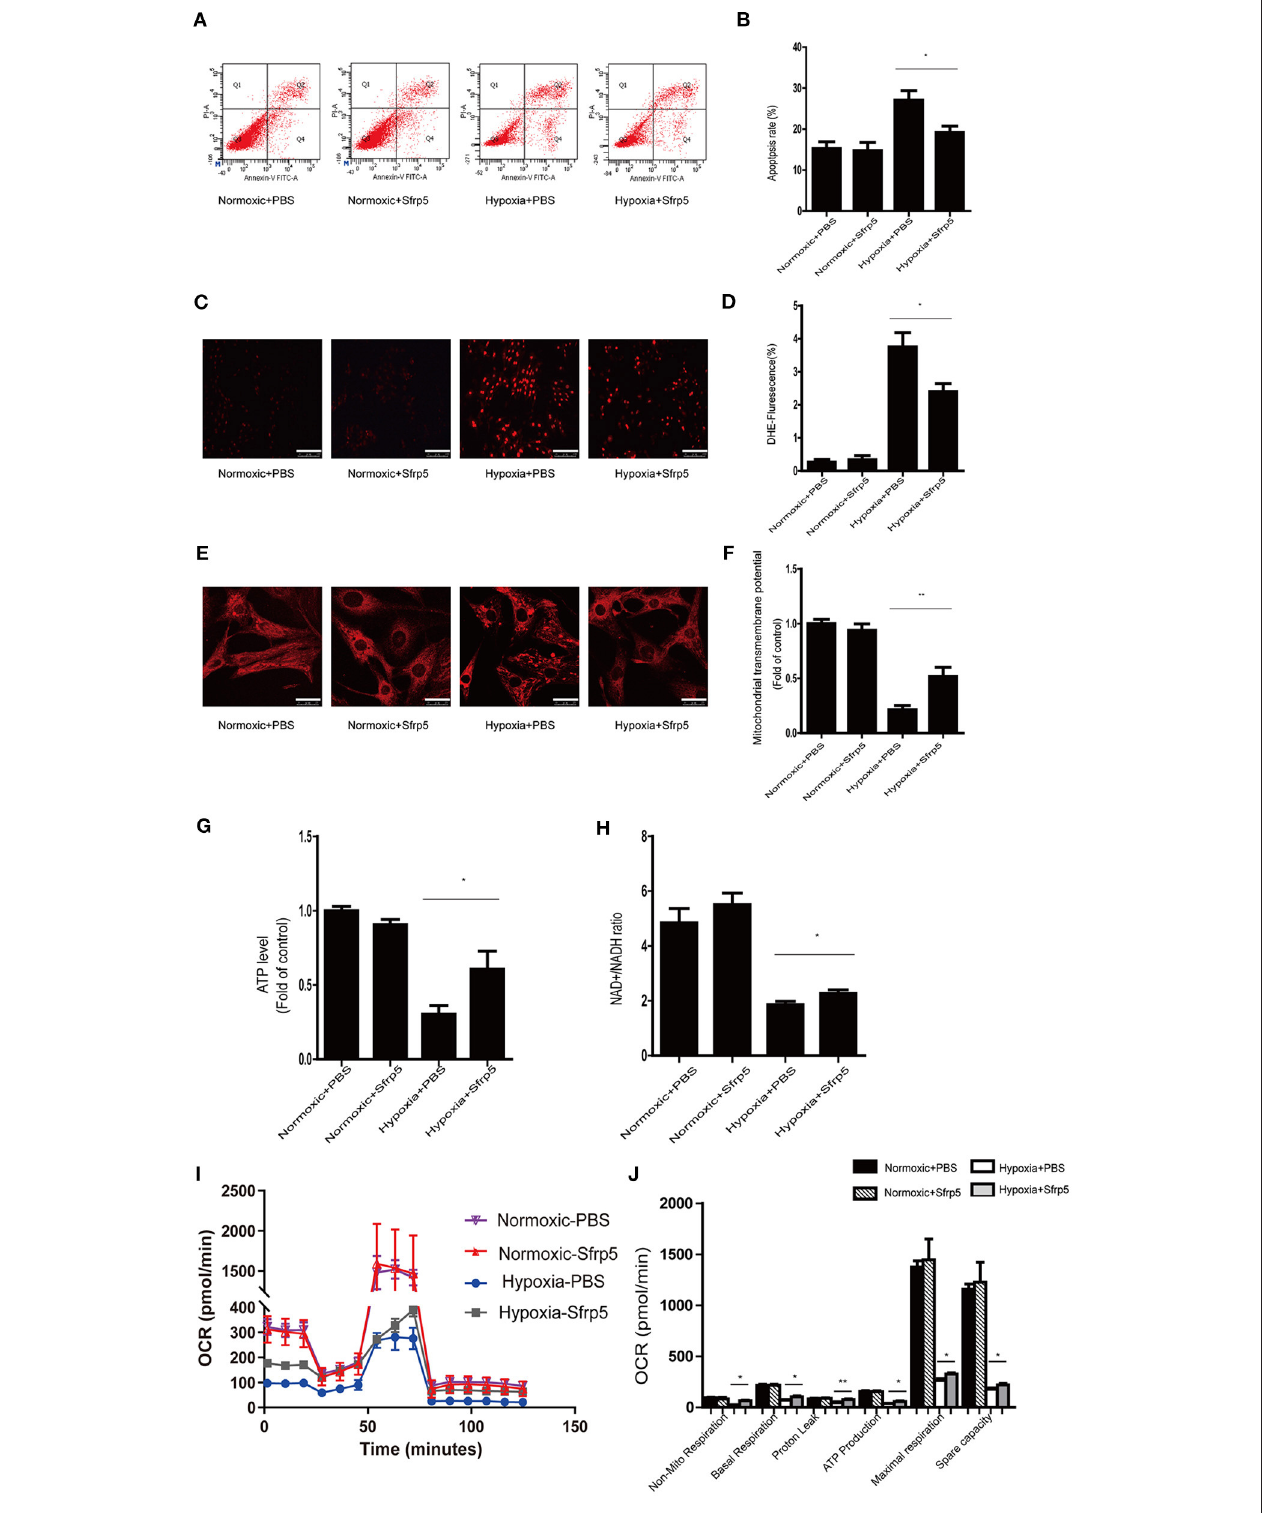
FIGURE 5 | Sfrp5 treatment attenuated hypoxia-induced myocardial oxidative stress and mitochondrial dysfunction in vitro . (A) The rate of apoptosis was detected by flow cytometry. (B) Statistical analysis of apoptosis calculated from the flow cytometry in A . (C) Representative images of DHE staining of PBS-treated